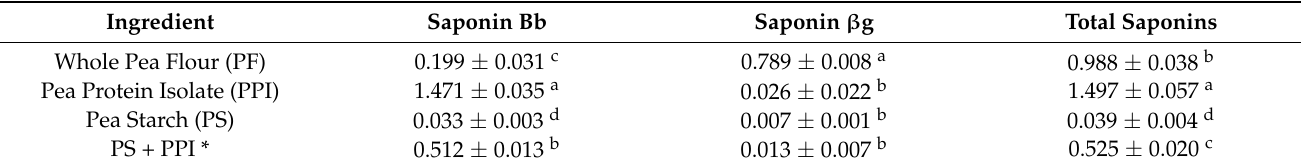
Table A2. Concentration of saponins (in g saponin · g − 1 dry matter) extracted from pea ingredients. Saponin Bb, saponin β g, and total saponin concentrations are detailed. Significantly different means ( p < 0.05) are represented by letters in